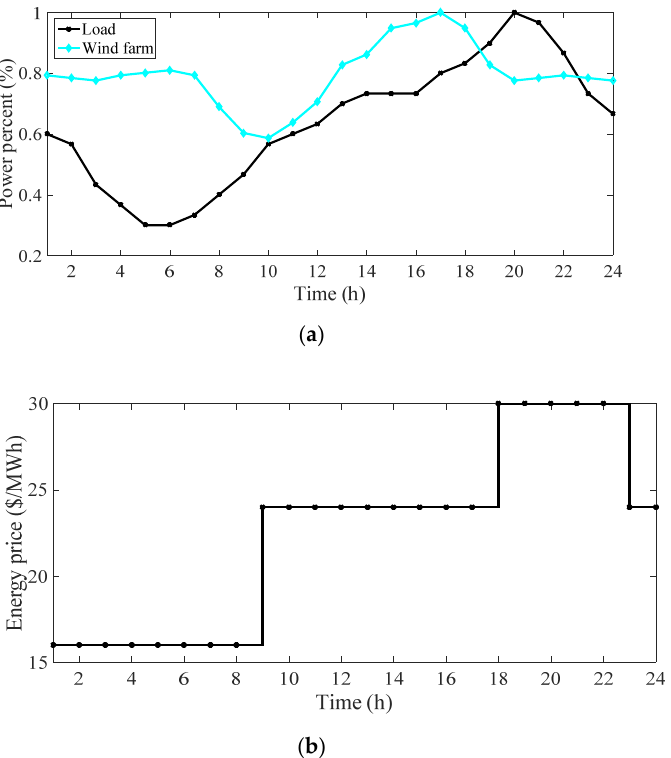
Figure 4. ( a ) Daily curve of power percentage for the load [21] and wind farm [48], ( b ) energy price [34].